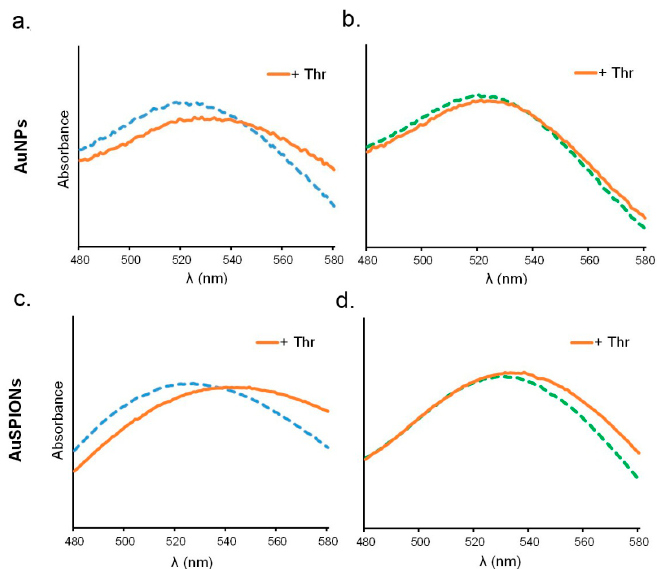
Figure 3. UV–Visible spectra of the complex formation between TBAs and α -thrombin at a molar ratio of (1:1). The curves represent the mixture of NPs–TBAs in the absence (dashed lines) and in the presence (orange continuous lines) of the α -thrombin. Blue represents unmodified TBAs and green, methylated TBAs: ( a , b ) display spectra recorded for AuNPs; and ( c , d ) display spectra recorded for AuSPIONs.